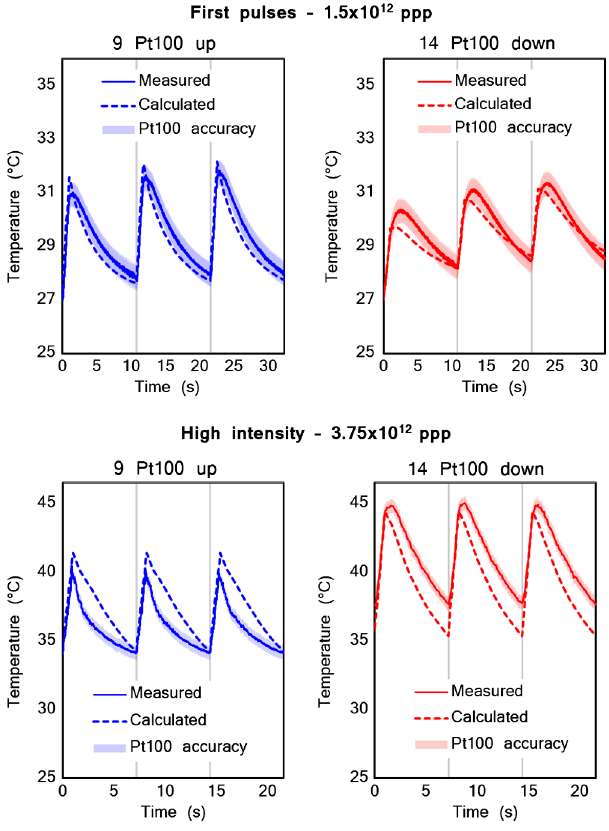
FIG. 16. Temperature measured by two sensors (upper Pt100 of block 9 and lower Pt100 of block 14) during three beam pulses at two different intensities: first beam pulses on target at an intensity of 1 . 5 × 10 12 ppp and a repetition rate of 10.8 seconds; 3 . 75 × 10 12 ppp after steady-state regime was reached under the BDF cycle. Pt100 accuracy calculated as (cid:2)ð 0 ; 3 þ 0 ; 005 (cid:3) T Þ °C for a given temperature T (class B accuracy). Comparison with the FEM simulations results under the same operational conditions.